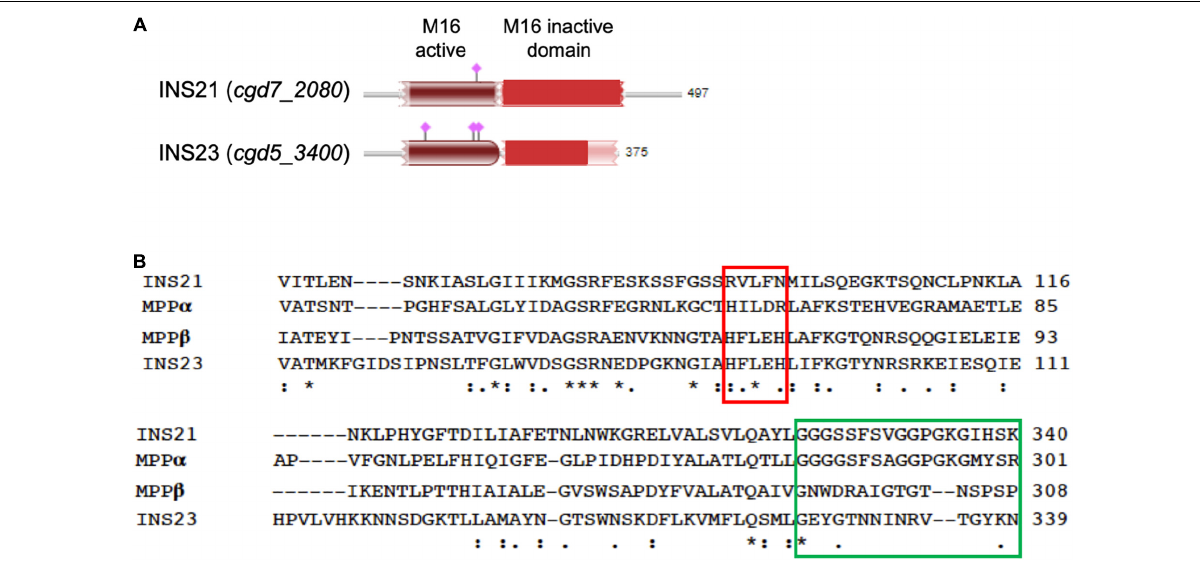
Frontiers in Microbiology |